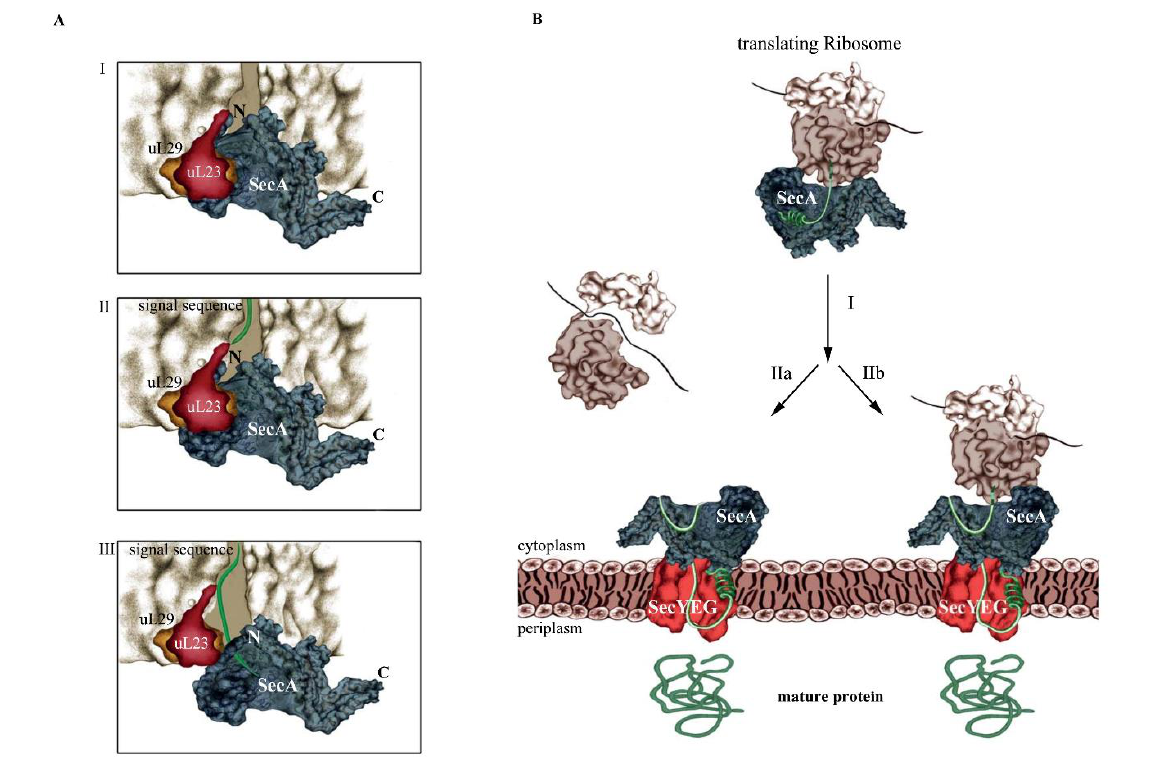
FIGURE 2: SecA-dependent co-translational targeting of secretory proteins to the SecYEG translocon. ( A) Scanning of the ribosomal tunnel by SecA. I. SecA contacts the intra-tunnel loop of uL23 II. In the presence of an emerging polypeptide, SecA retracts from the tunnel interior. III. SecA traps the signal sequence. N and C correspond to the N-terminus and C-terminus of SecA, respectively. (B) Co-translational targeting by SecA. I. SecA targets the nascent secretory protein to the SecYEG channel. At the membrane, SecA is released from the ribosome and binds to the SecYEG translocon. Whether the secretory protein is completely released from the ribosome before translocation starts (IIa) or whether translocation starts already during ongoing translation is unknown